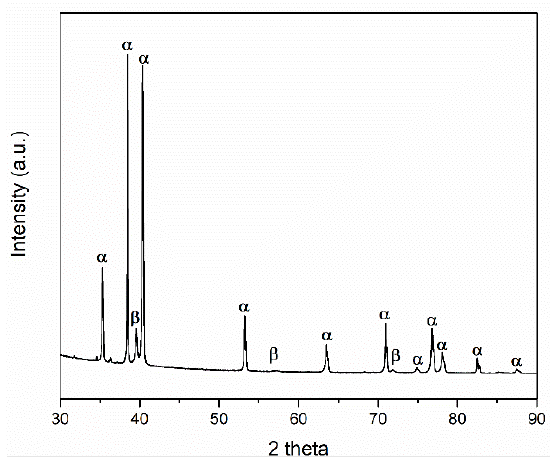
Figure 6. XRD pattern of Ti-6Al-4V DPF after annealing at 925 °C for 2 h.